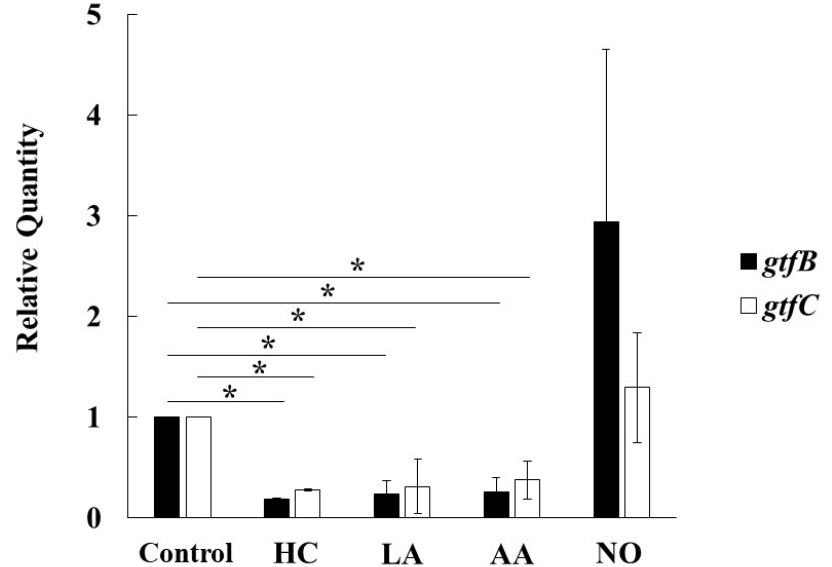
Figure 7. Effects of initial pH condition on expression of gtfB and gtfC in the MVs. Expression